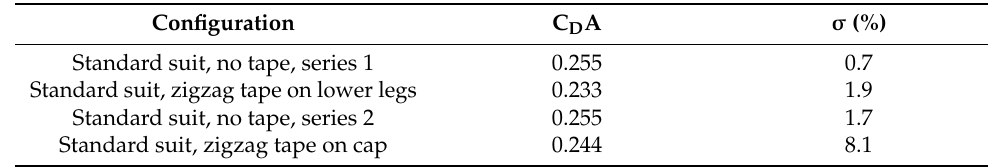
Table 1. Averages over five runs of the drag area C D A of three configurations showing the effect